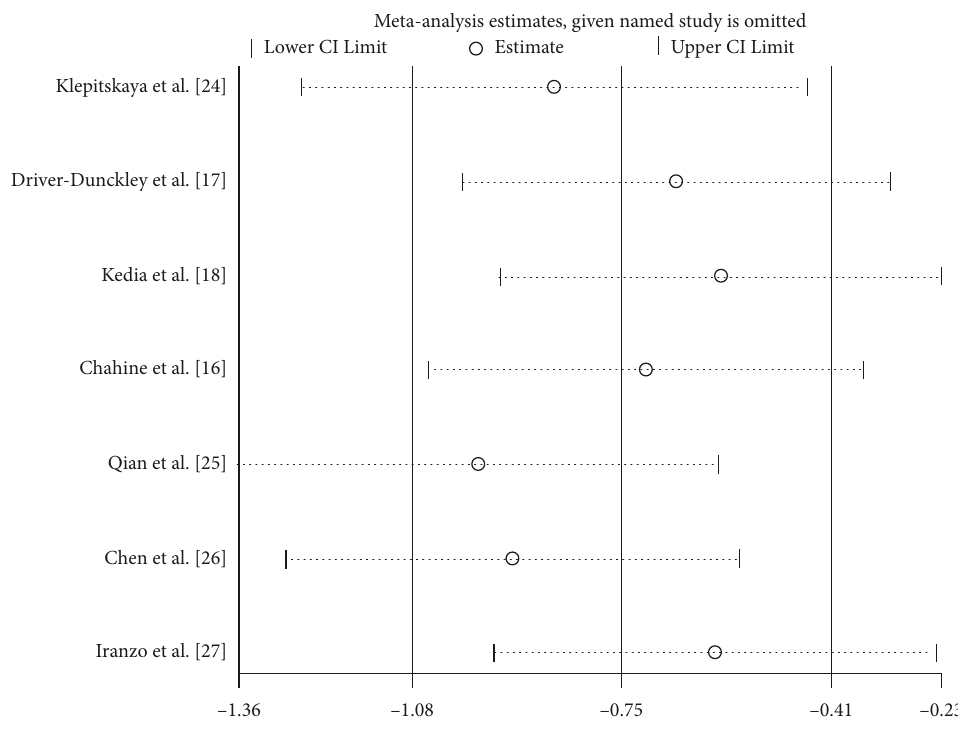
Figure 4: Sensitivity analysis of the summary OR coefficients on sleeping symptoms observed presurgery and